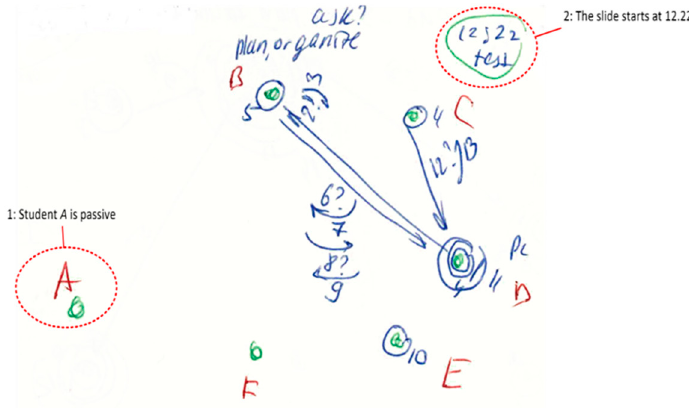
Figure 1. Interaction diagram: communication situation 1 (reproduced from [51] by permission).